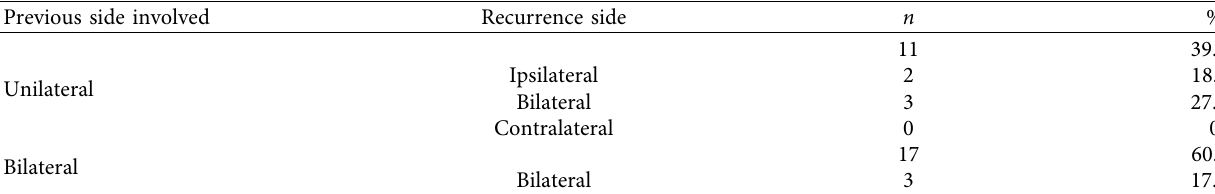
Table 6: Disease recurrence pattern